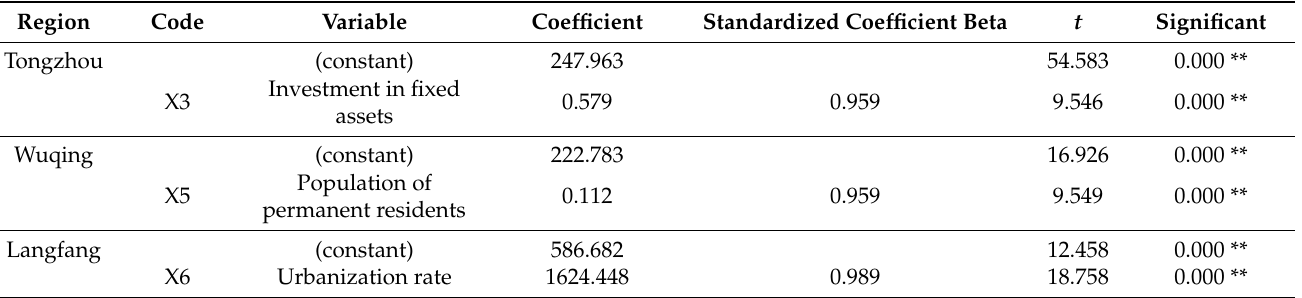
Table 6. Estimation results of the driving factors of Tongzhou, Wuqing, and Langfang by stepwise regression